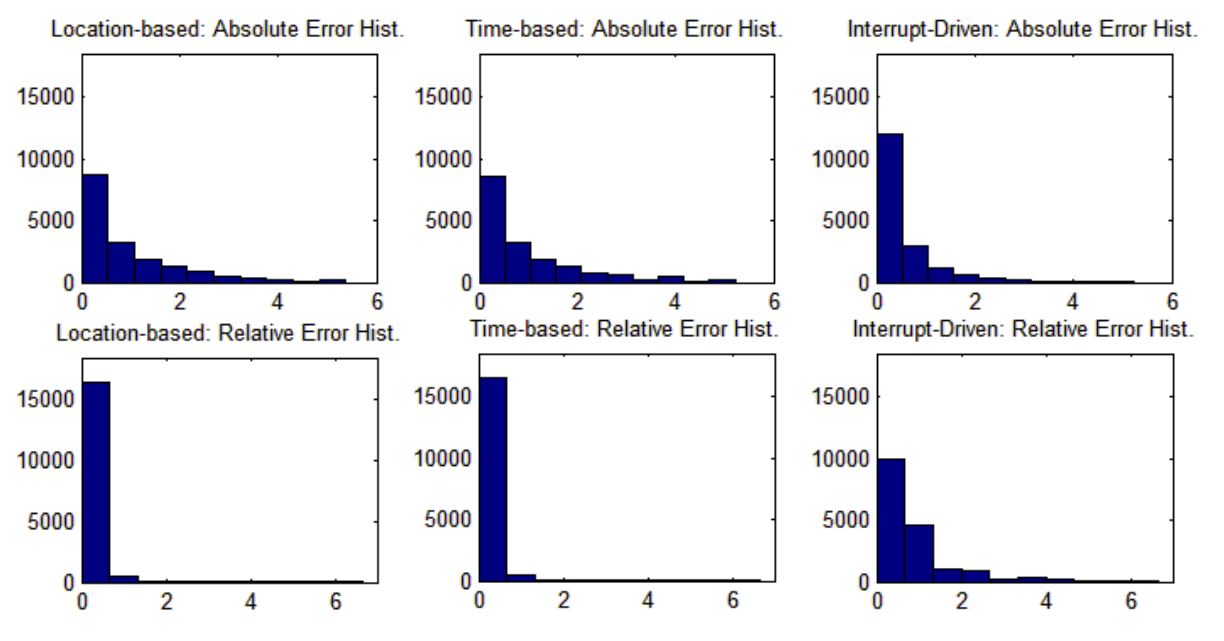
Figure 6. Histogram results of the error